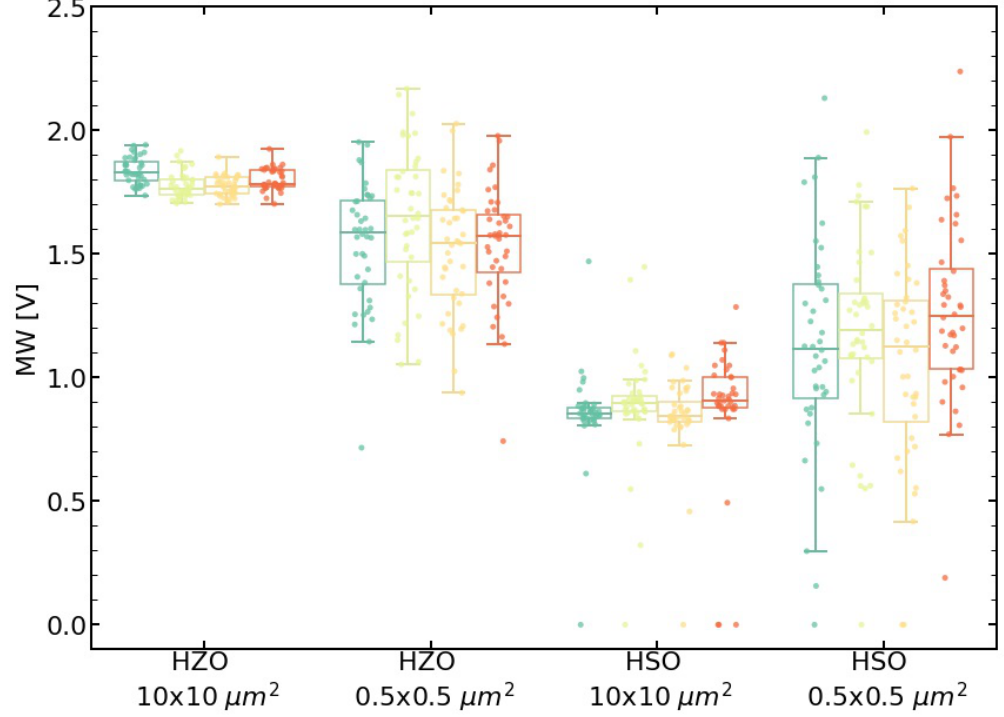
Figure 4. In-die variability of the memory window is smaller for HZO as well as for larger devices. The die-to-die variability of the four dies (visualized by different color) is rather